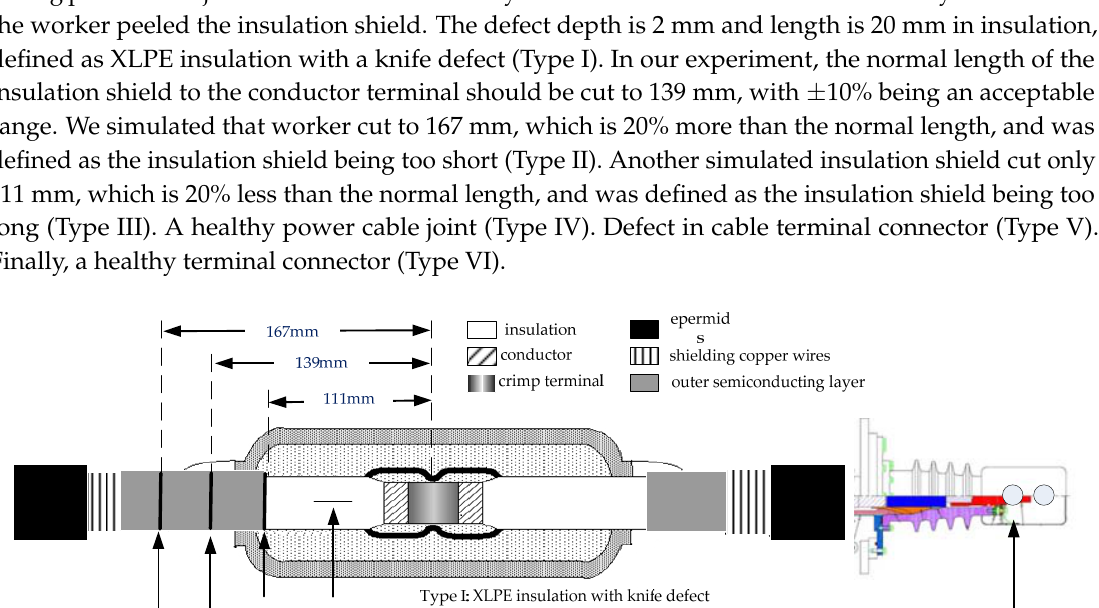
Figure 5. Block diagram of partial discharge (PD) measurement experiment.